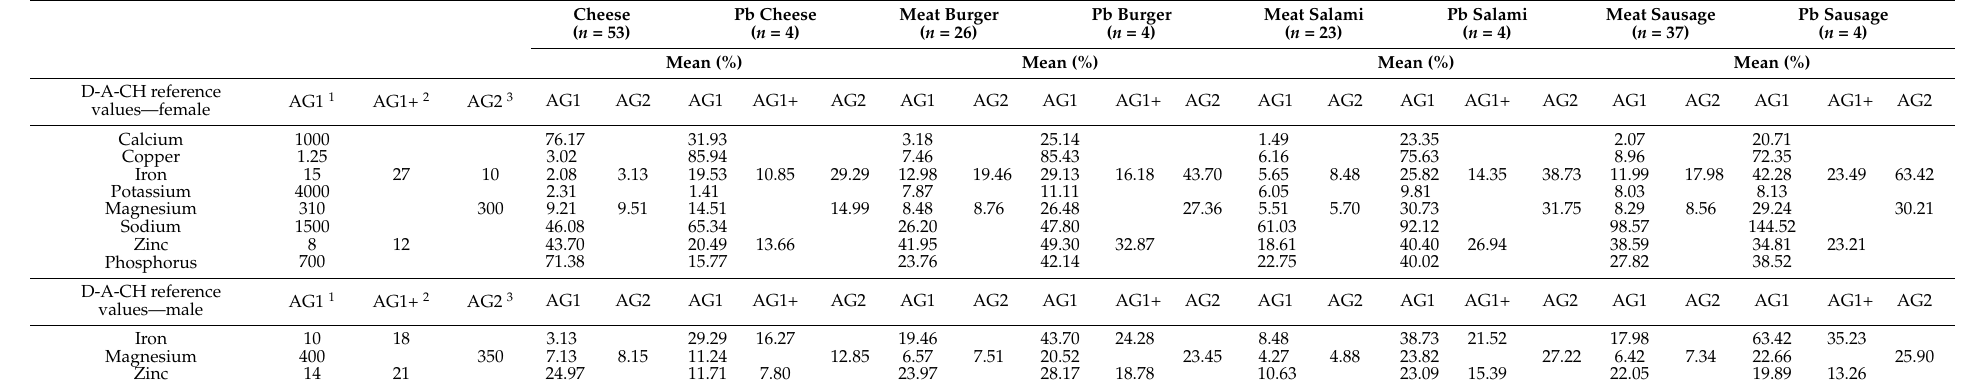
Table 7. Coverage of the daily mineral requirements by pb alternative products compared to animal-based products *. Percentage related to the recommendations of the D-A-CH reference values, given in mg per 100 g of foods, and related to gender and age groups (19–25 Y (years) and ≥ 65